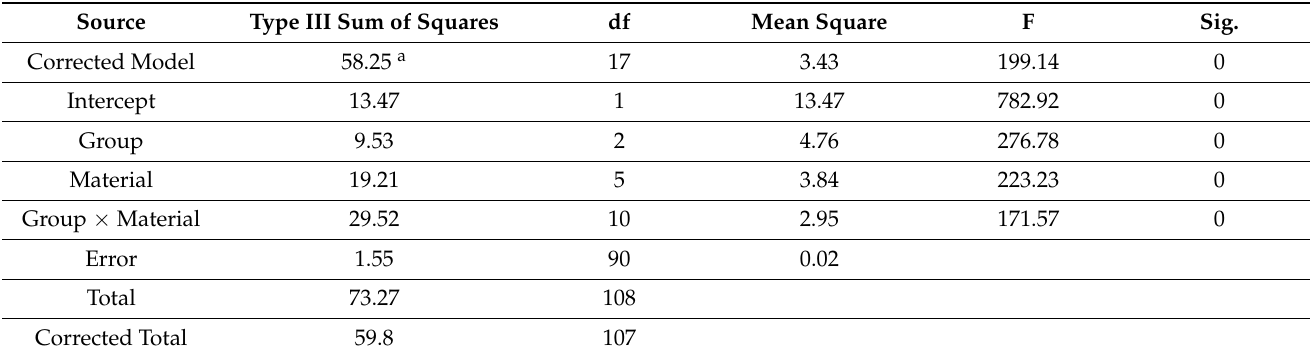
Table 3. Two-way ANOVA (Tests of Between-Subjects Effects).